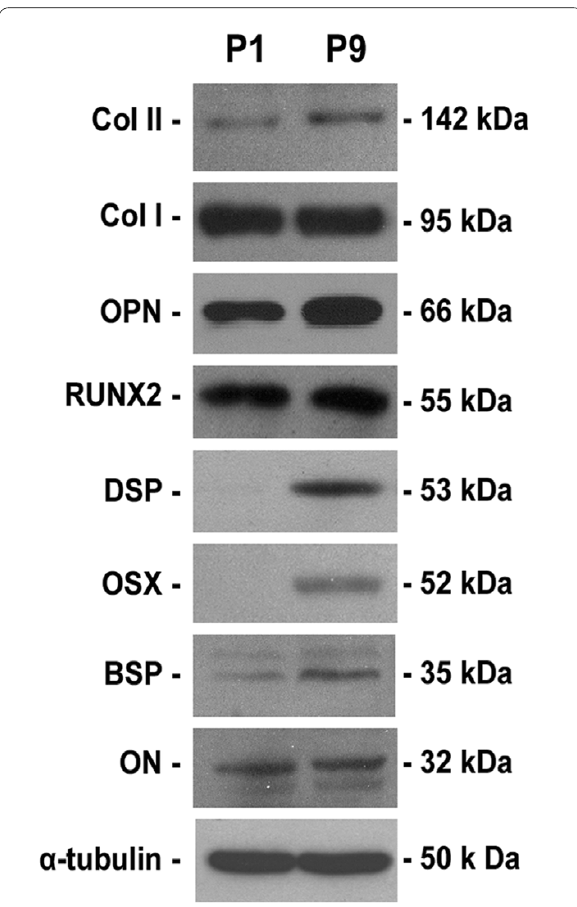
Figure 3 Protein expression of DPSCs at different passages by western blot analyses . α-tubulin was used as a control.